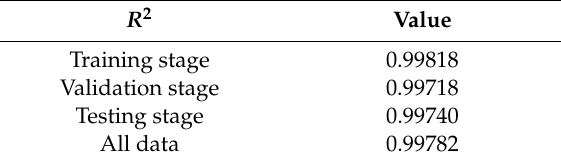
Table 3. Coe ffi cient of determination obtained for the best analyzed neural